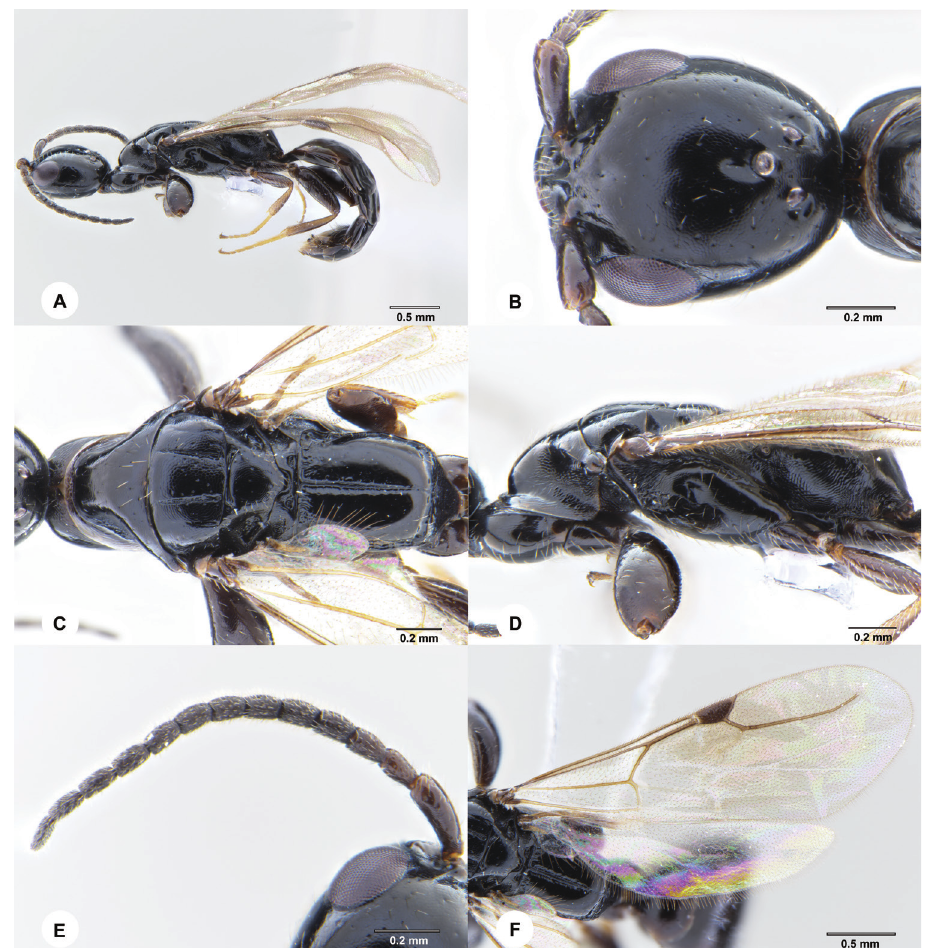
Figure 2. Foenobethylus robusta Li & Chen, sp. nov., male, holotype (SCAU 3042645) A lateral habitus B head, dorsal view C mesosoma, dorsal view D mesosoma, lateral view E antenna F